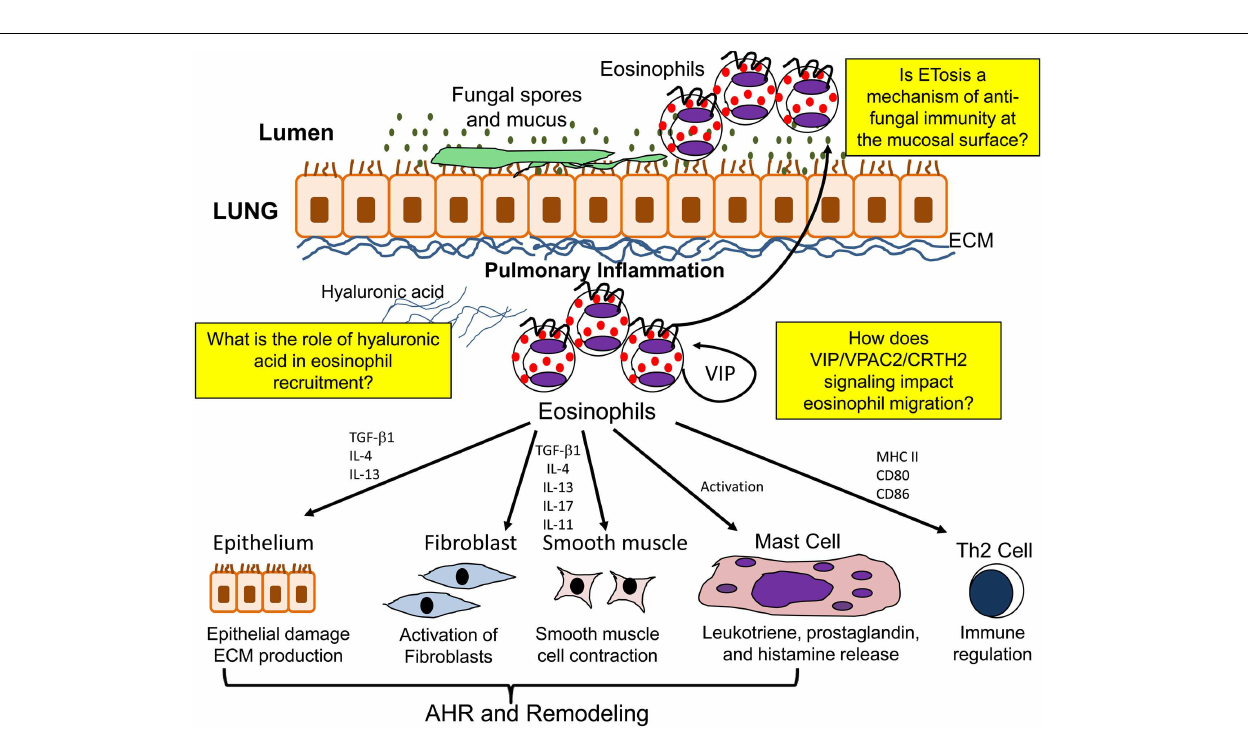
FIGURE 2 | Function of eosinophils in the allergic lung. In the allergic lung eosinophils are activated to release a number of mediators which may contribute to airway hyperresponsiveness (AHR), airway remodeling, immunomodulation, and